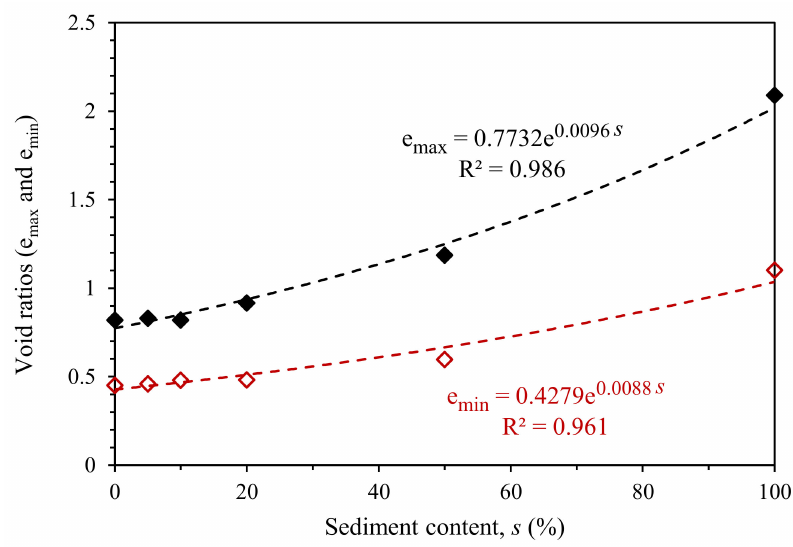
Figure 3. Regressions of sediment content and void ratios.